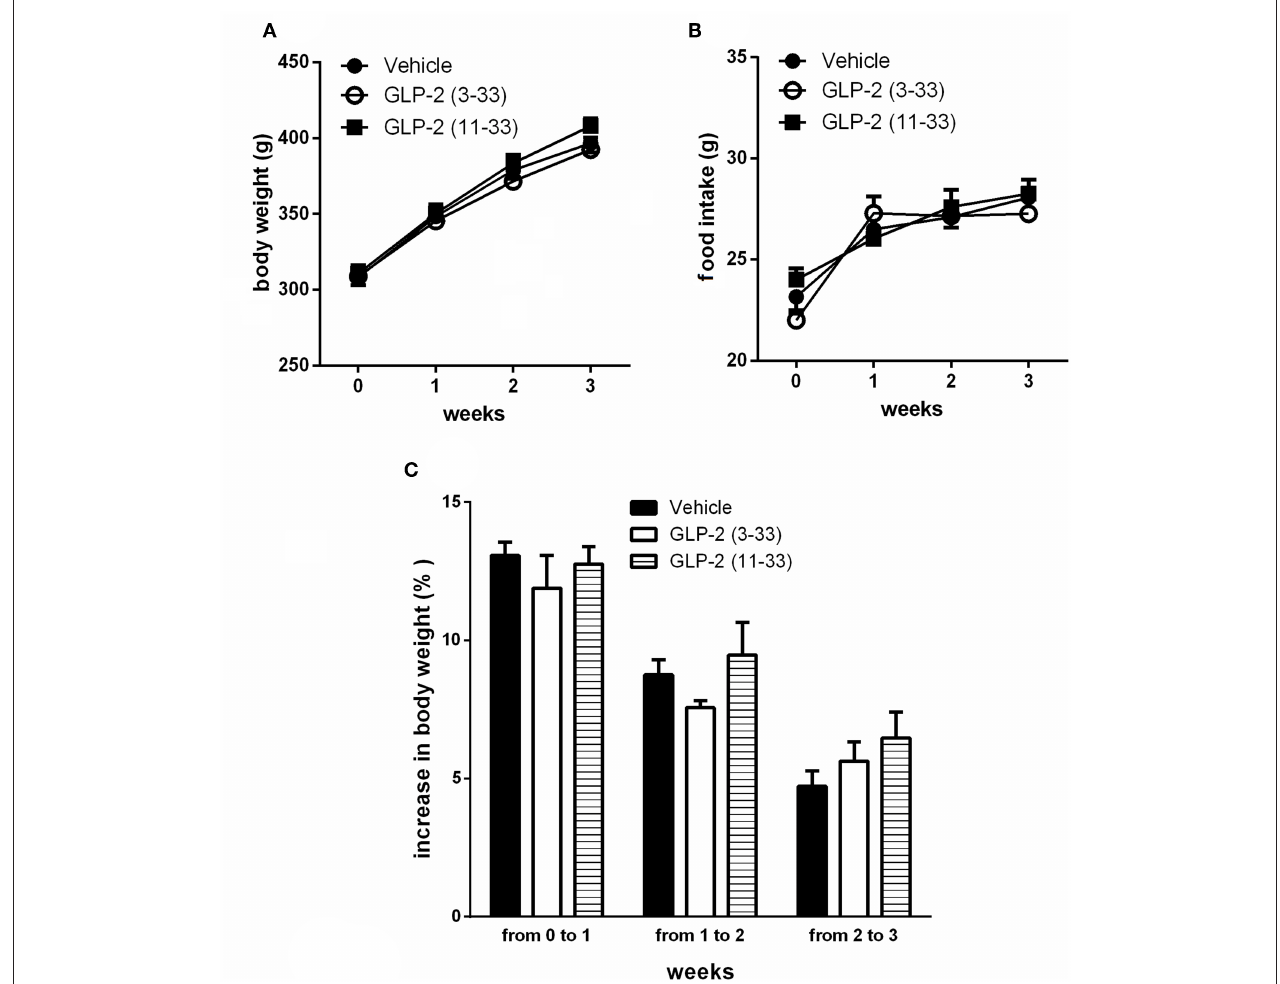
FIGURE 3 | Effects of the subchronic treatment with GLP-2(11-33) (25 nmol/kg b.w.), GLP-2(3-33) (25 nmol/kg b.w.) or vehicle treated on body weight (A) , food intake (B) , and body weight gain (C) . Data are mean values ± S.E.M ( n = 6